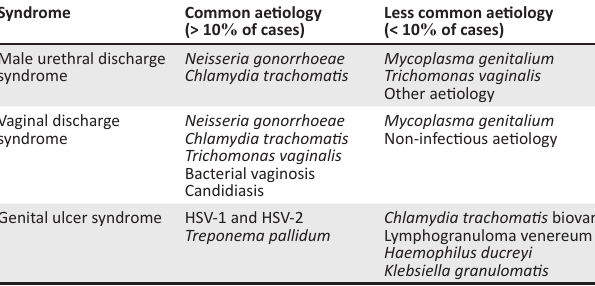
TABLE 1: Microbial aetiology of sexually transmitted infection